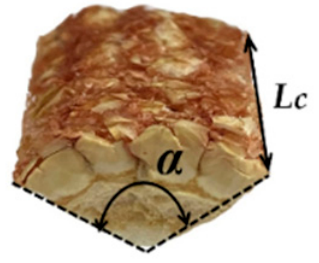
Figure 6. Characteristic size of the corn